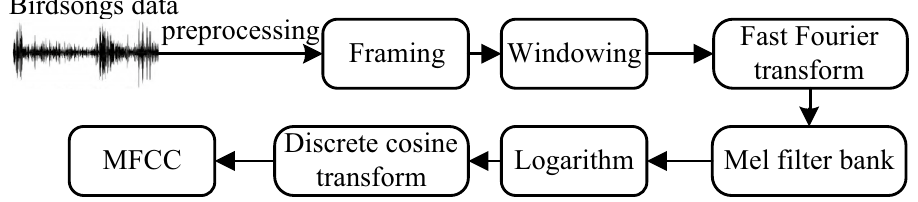
Figure 3. Process of extracting MFCC feature parameters.